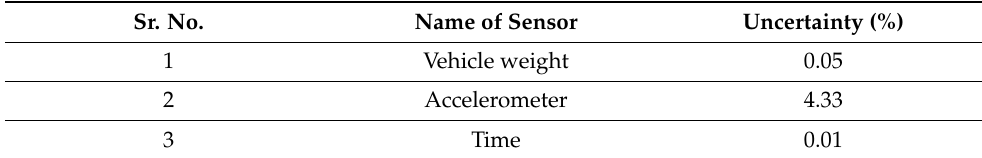
Table 1. Estimated uncertainties of measured parameters. Sr.